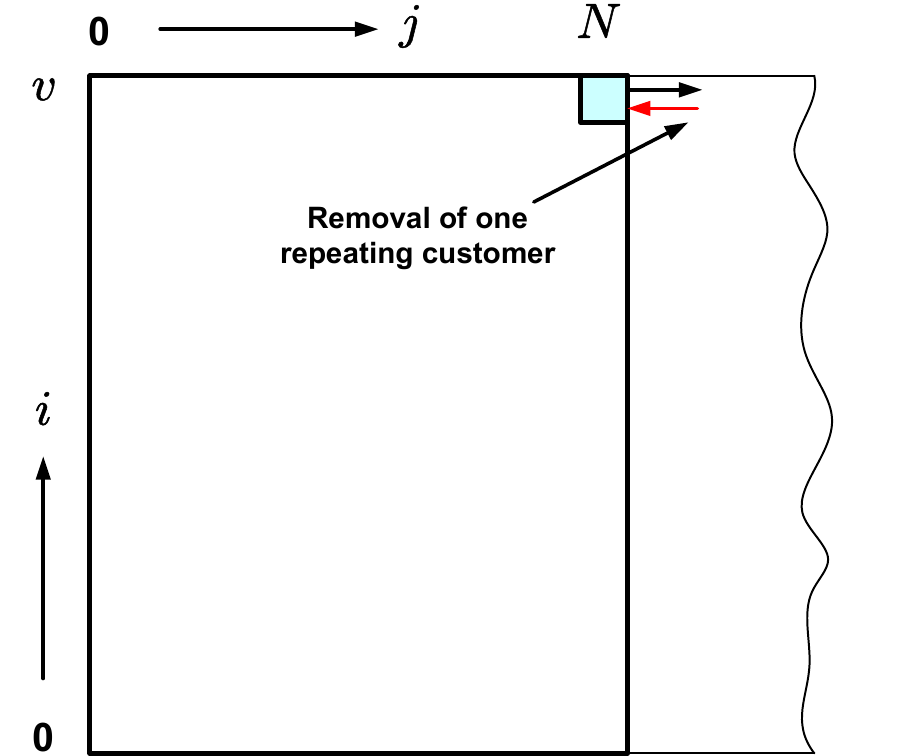
Figure A3. Results of primary truncation of the used state space S